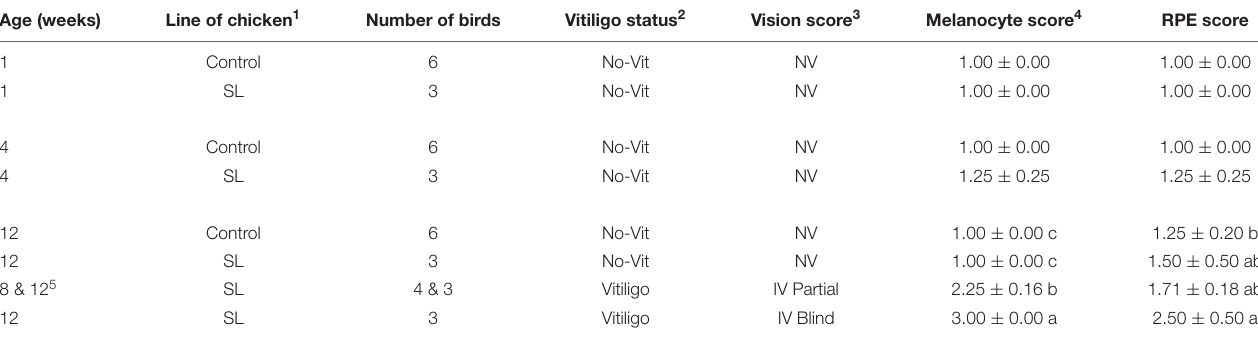
TABLE 2 | Choroidal melanocyte and retinal pigment epithelium (RPE) degeneration scores for eyes which were collected from age-matched controls and Smyth line chickens with and without vitiligo. Age (weeks) Line of chicken